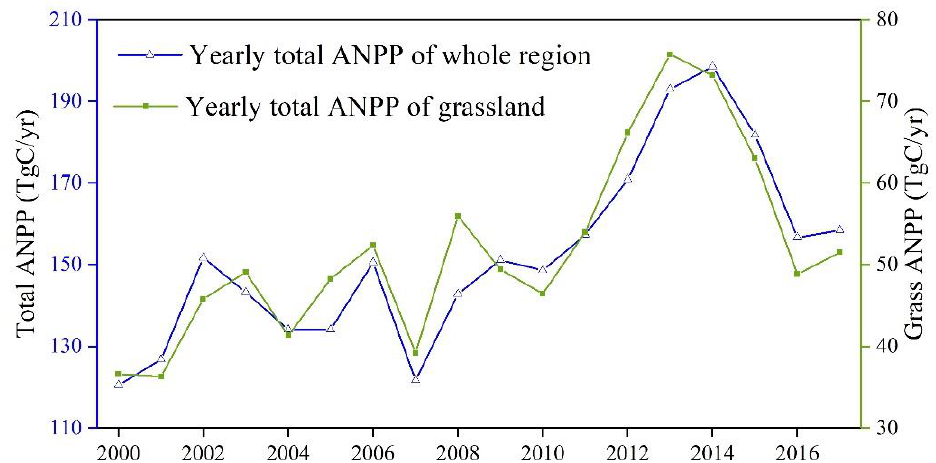
Figure 3. The variation in the total ANPP (a) and total grasslands NPP (b) of eastern Inner Mongolia from 2000 to 2017.